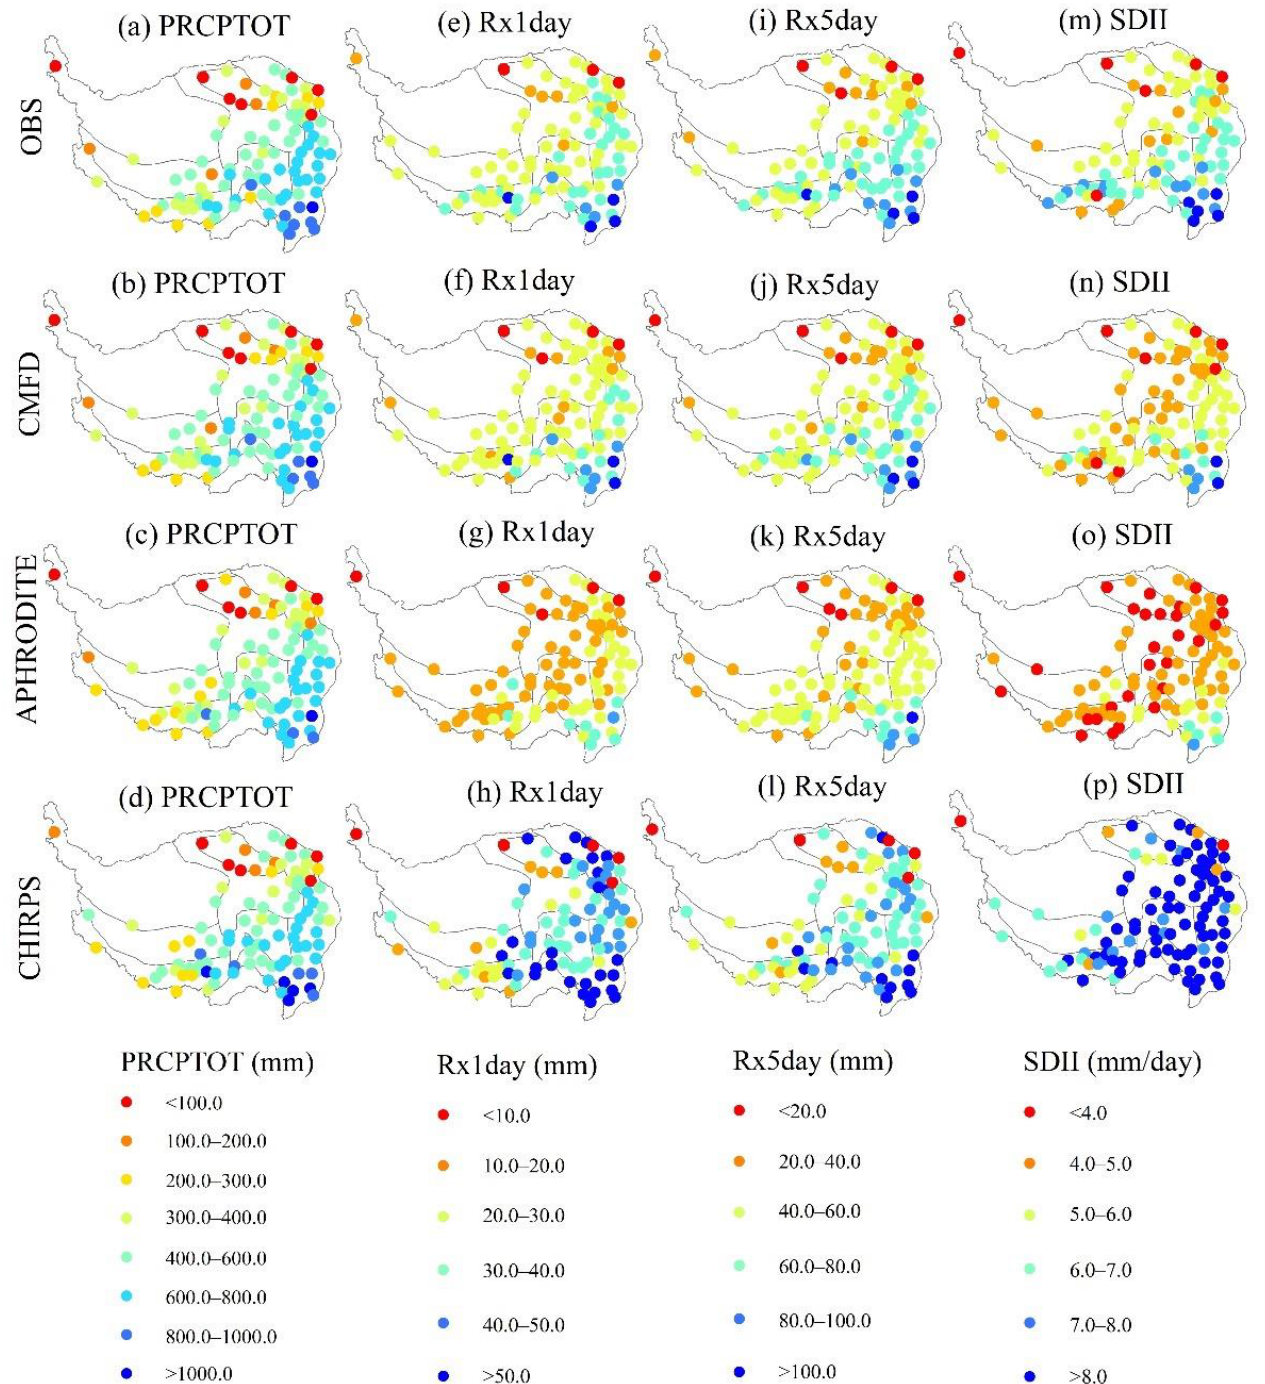
Figure 14. Mean spatial distribution of non-threshold indices from 1981–2014: PRCPTOT, Rx1day, Rx5day, and SDII.